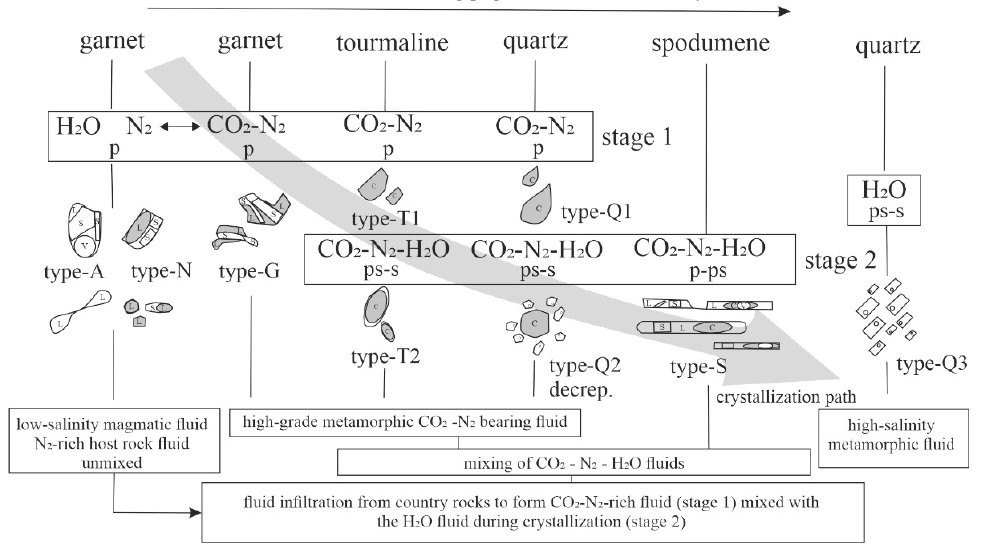
Figure 7. Origin and relationship between different fluids entrapped in studied host minerals.